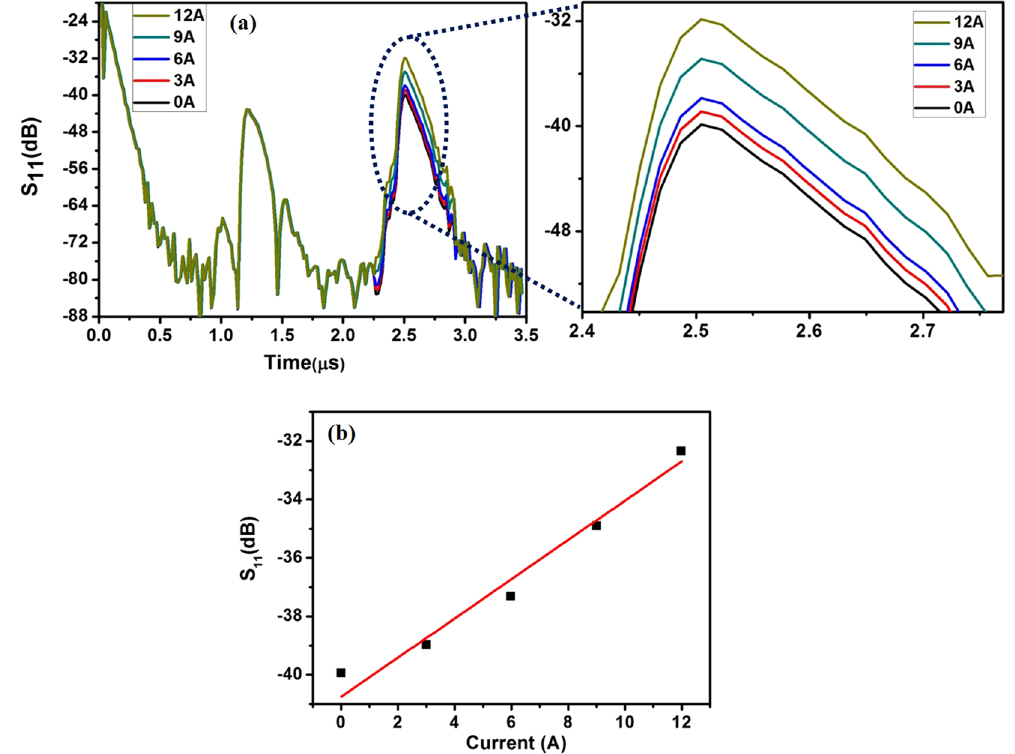
Figure 7. ( a ) Amplitude variations of the second reflection peak with respect to current flowing through conductor, ( b ) Calibrated amplitude variation of the sensor in terms of current flow in conductor